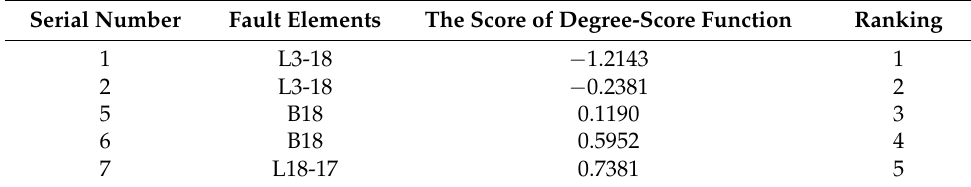
Table 5. Results sorted with